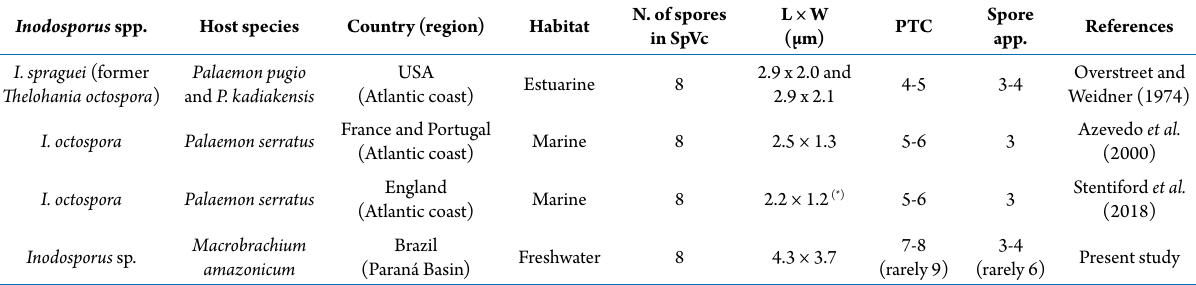
Table 1. Comparison of the spore characteristics of Inodosporus species. Inodosporus